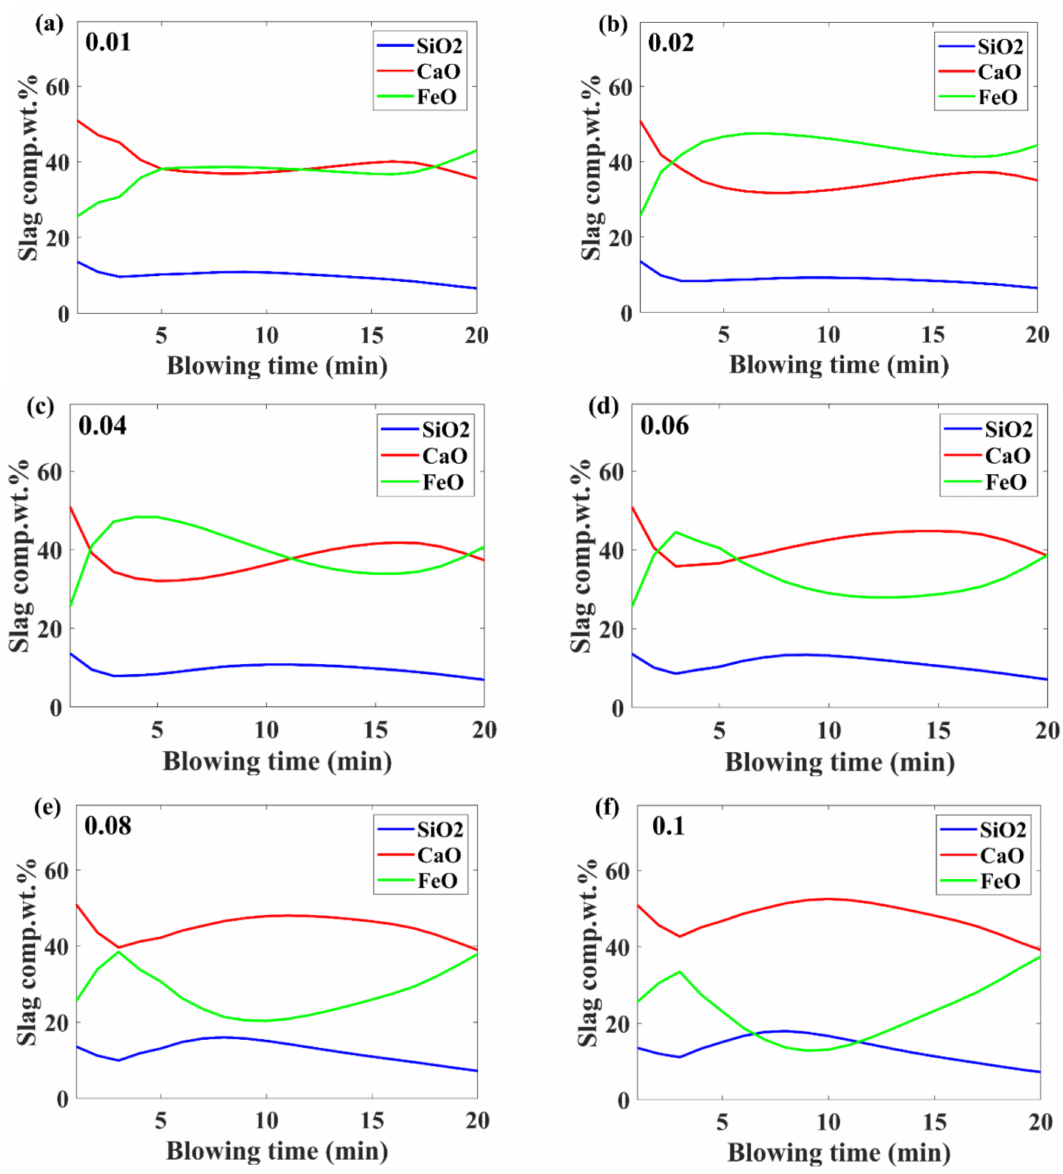
Figure 4. Slag compositions variations of wt.% SiO 2 (blue), CaO (red) and FeO (green) with blowing time at ( a ) 0.01 inialpha, ( b ) 0.02 inialpha, ( c ) 0.04 inialpha, ( d ) 0.06 inialpha, ( e ) 0.08 inialpha, and ( f ) 0.1